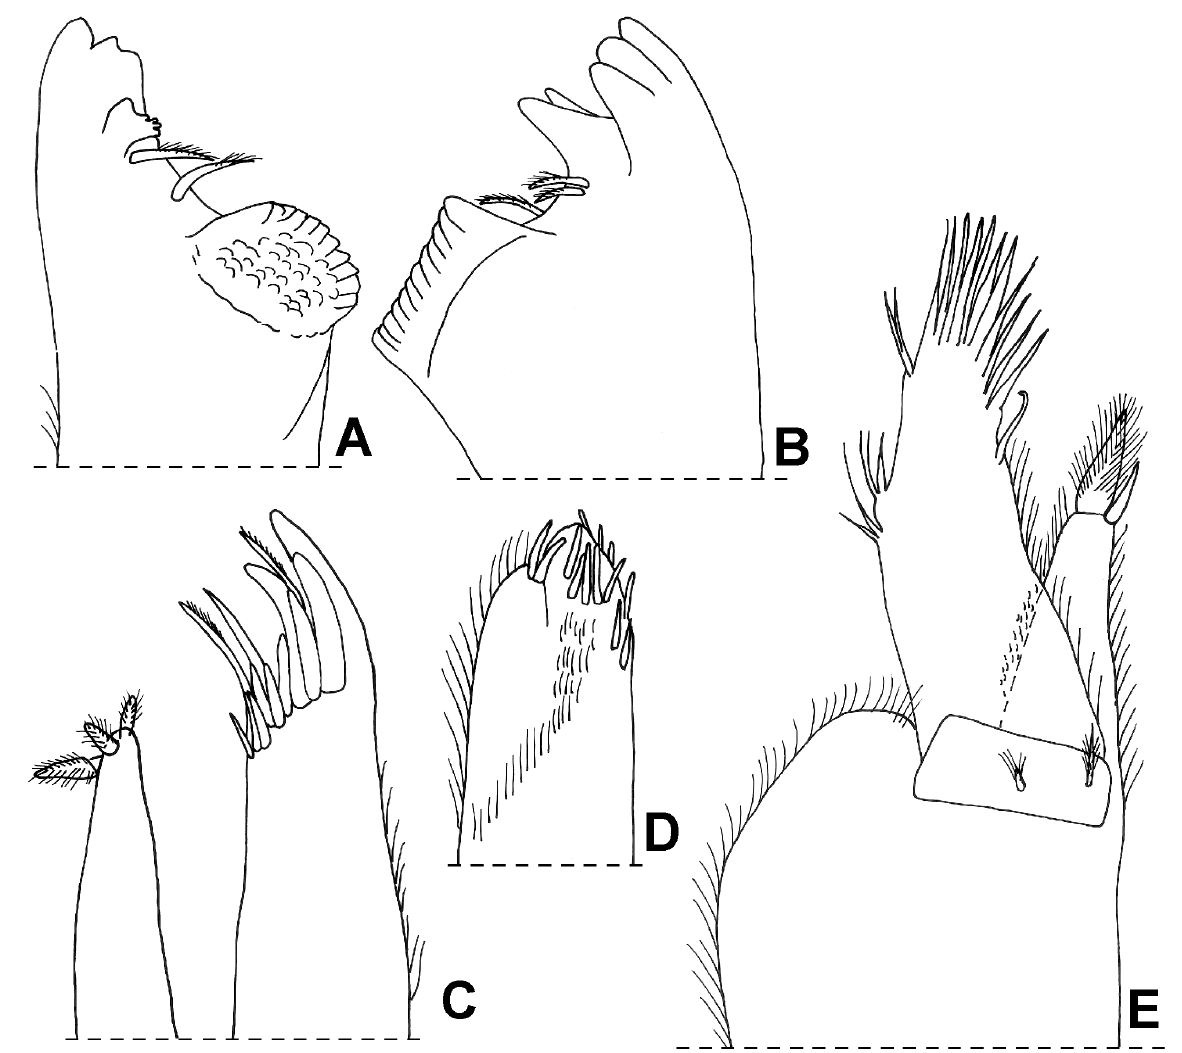
Fig. 5. Trichoniscoides bellesi Reboleira & Taiti sp. nov. from Algar do Javali, Montejunto, paratype, ♀. A . Right mandible. B . Left mandible. C . Maxillula. D . Maxilla. E .